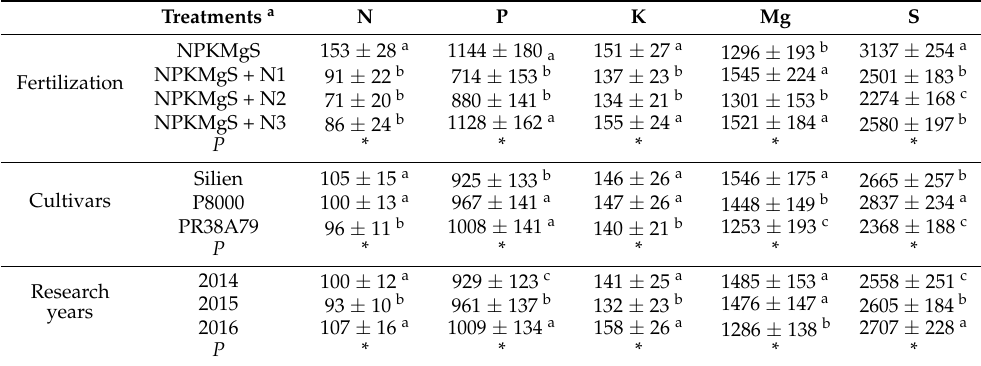
Table 8. Physiological efficiency of nitrogen, phosphorus, potassium, magnesium and sulphur treatment (kg · kg − 1